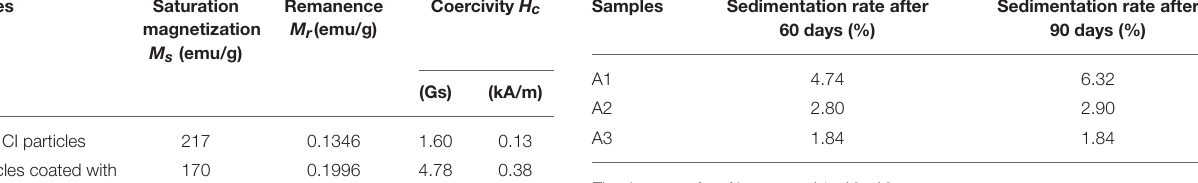
TABLE 4 | Sedimentation rate of MR fluids with different dosages of grafting agent. Samples